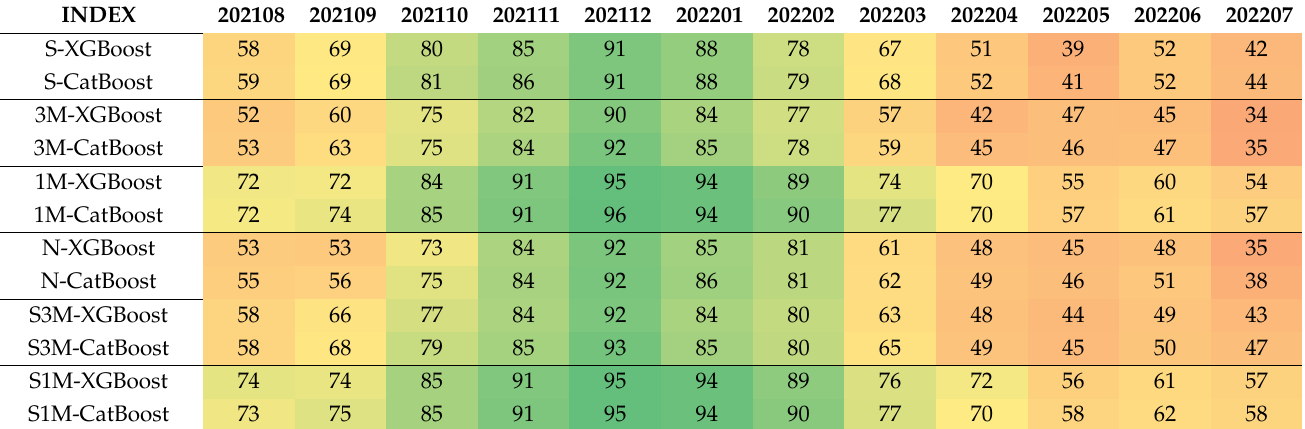
Table 1. Average skill score RMSE (%) per month per model.